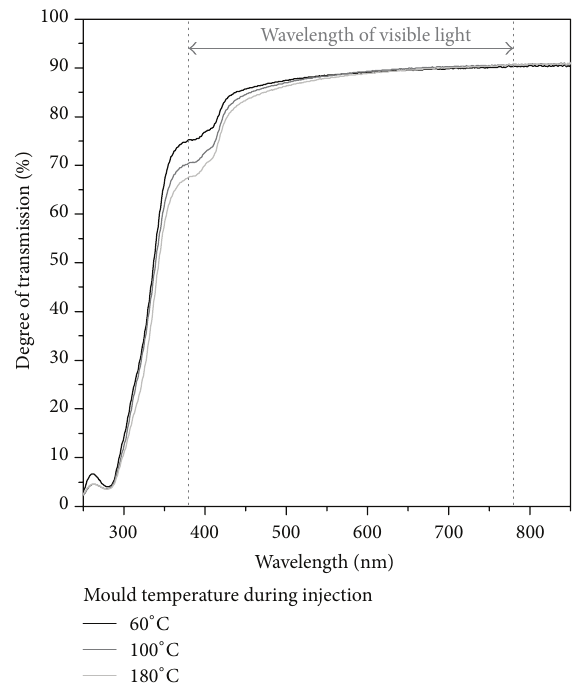
Figure 8: Normalized light transmission of the specimens in dependence of cooling conditions as function of the